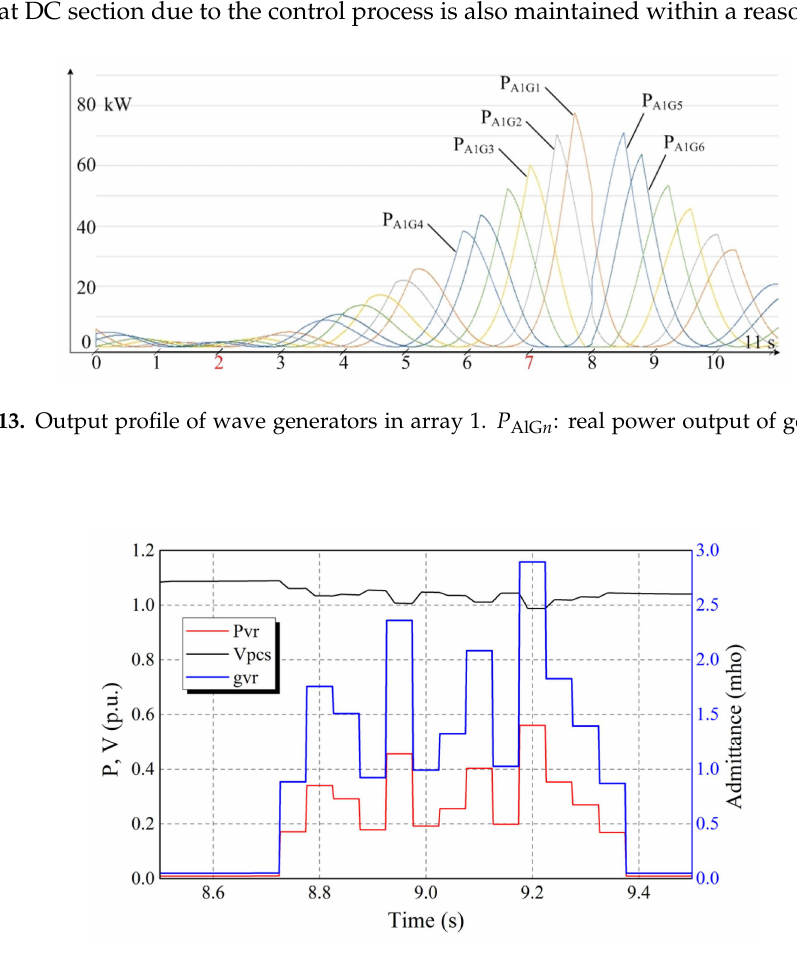
Figure 14. Admittance and pcs voltage variation in Case 1 (8.5–9.5 s).